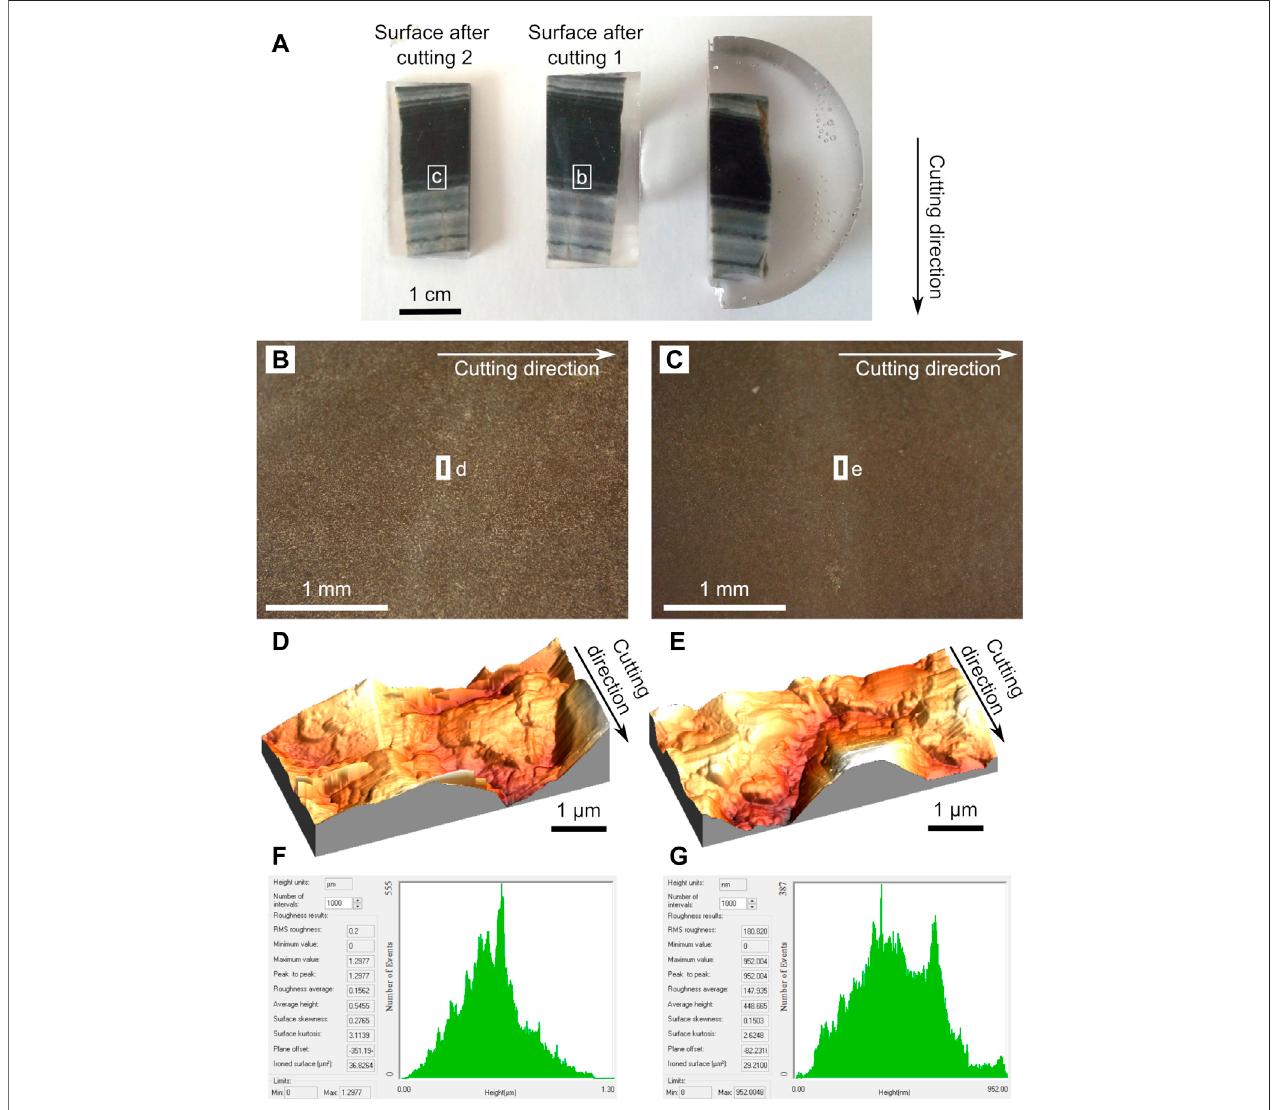
FIGURE 7 | Chert samples after cutting with the Struers Secotom-10 disc saw. (A) Photograph of the three pieces of sample. (B,C) Optical microscopy images in re fl ected light of the areas indicated in (A) . (D,E) AFM images of the areas indicated in (B,C) respectively and (F,G) associated roughness measurement.